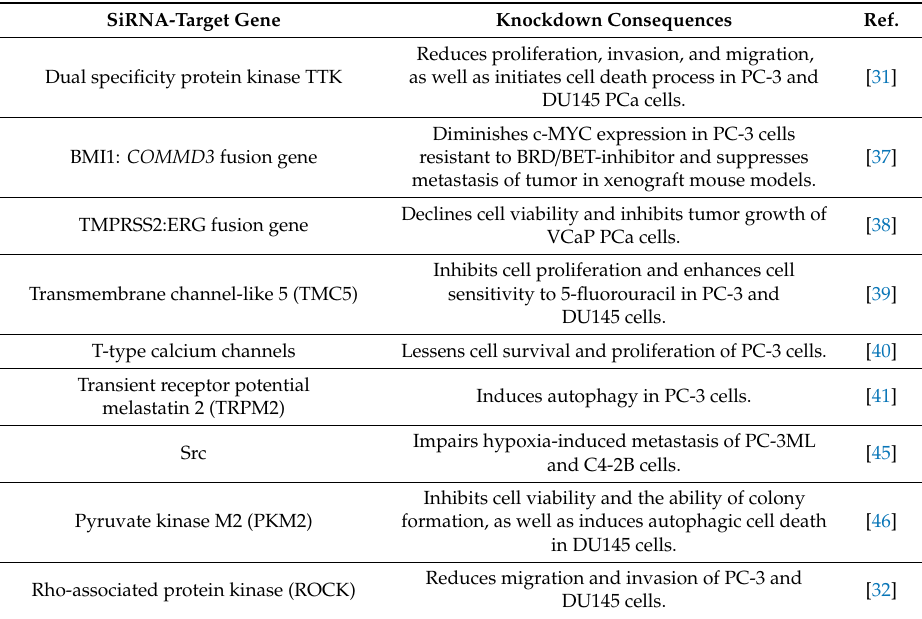
Table 1. Potential targets for siRNA treatment in prostate